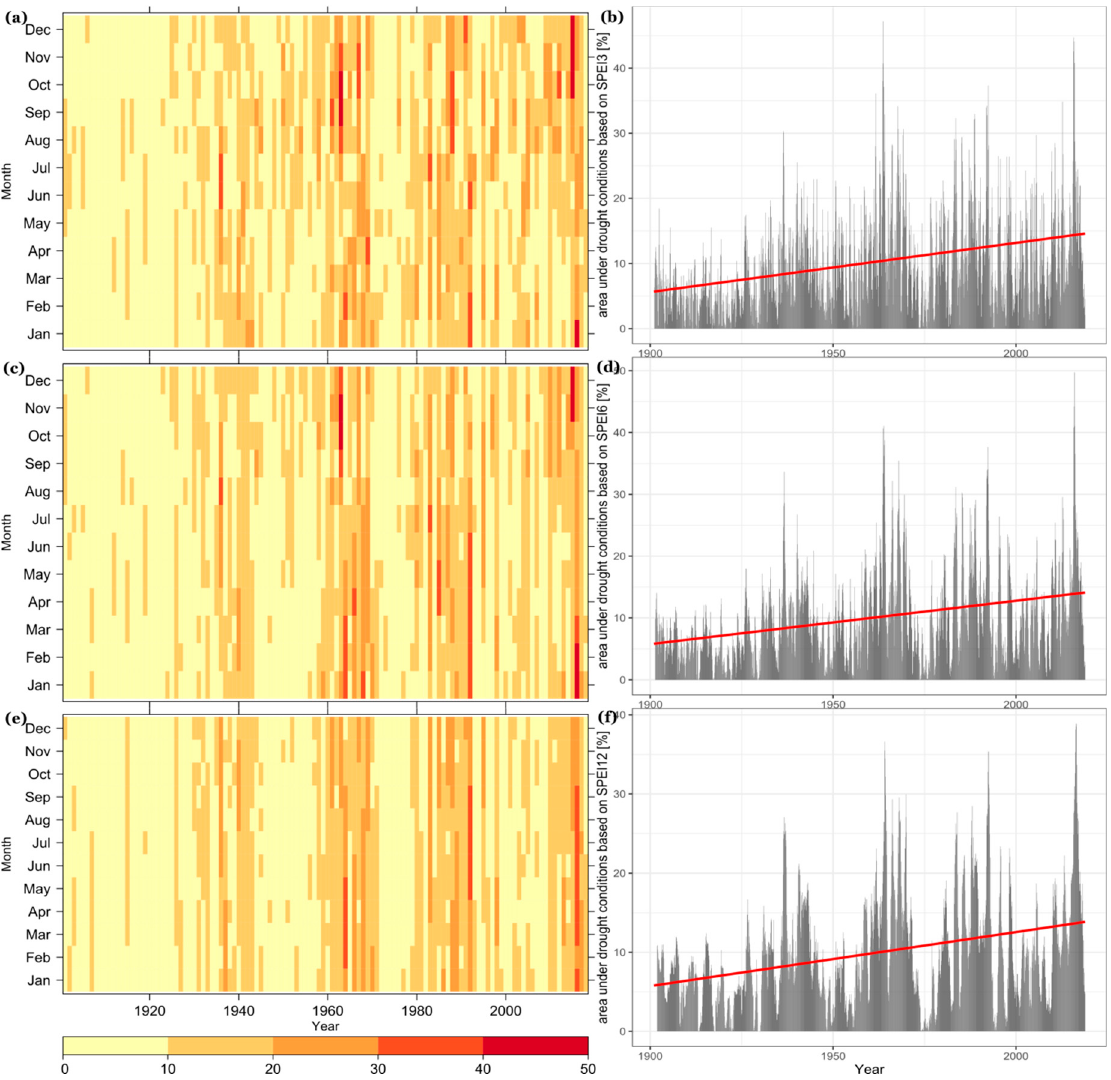
Figure 4. Percentage of area under drought conditions according to the values of: ( a , b ) SPEI3; ( c , d ) SPEI6; and ( e , f ) SPEI12 in the ARB during 1901-2018. The calculation of the drought spatial coverage is based on the number of pixels with values of SPEI ≤ − 1.00, regardless of the time scale used. The red line indicates fitted line. The reference period is 1901-2018.